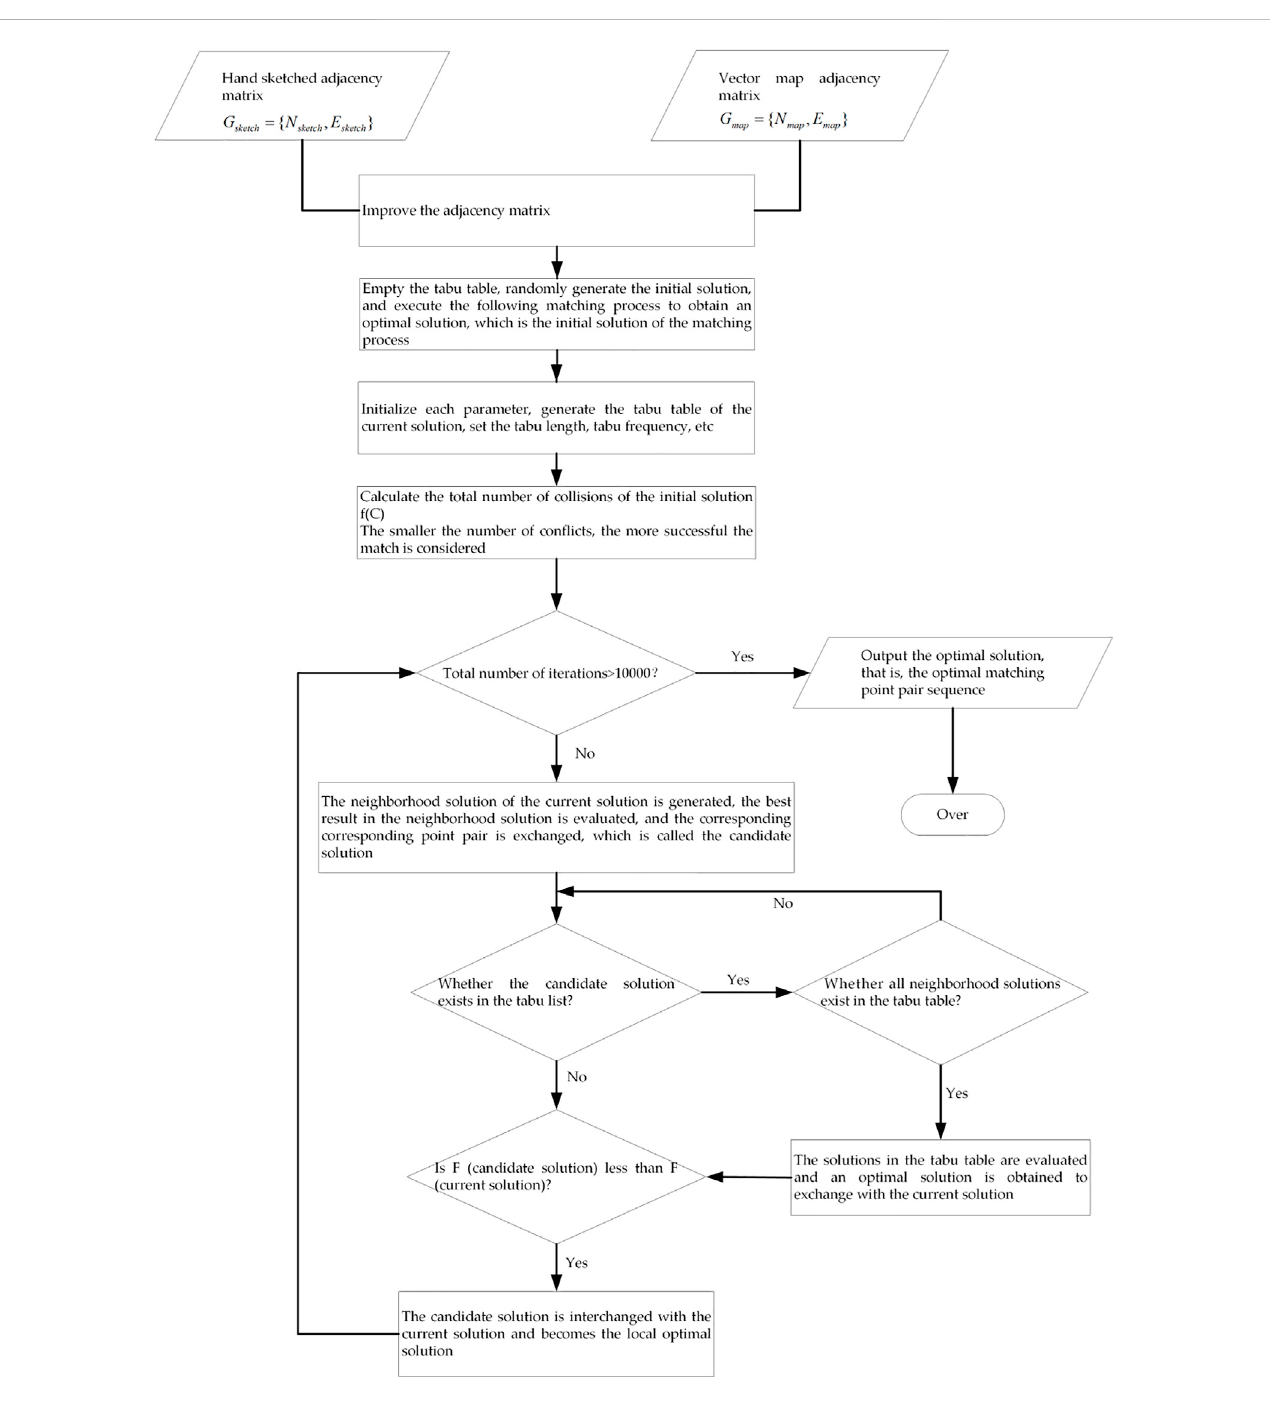
FIGURE 7 Flow chart of sketch and vector map matching